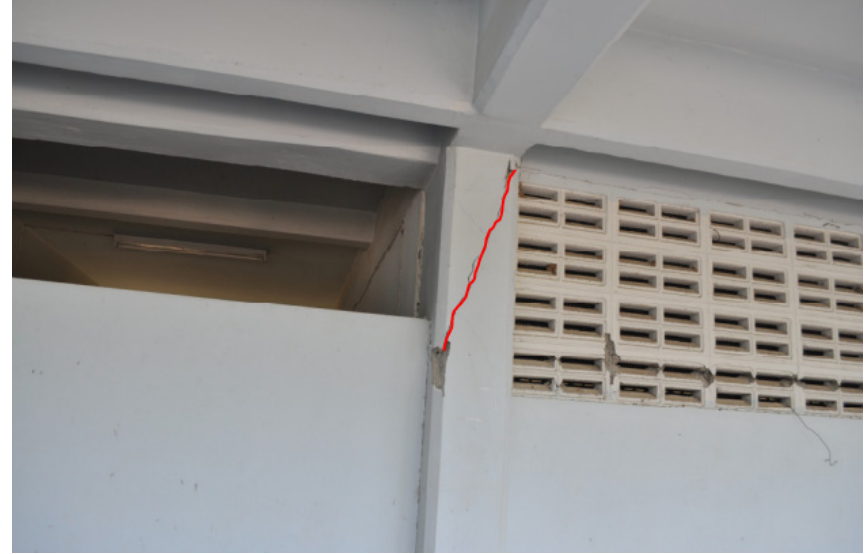
Figure 1. Damage of a building with small columns in Chiang-Saen District [7].